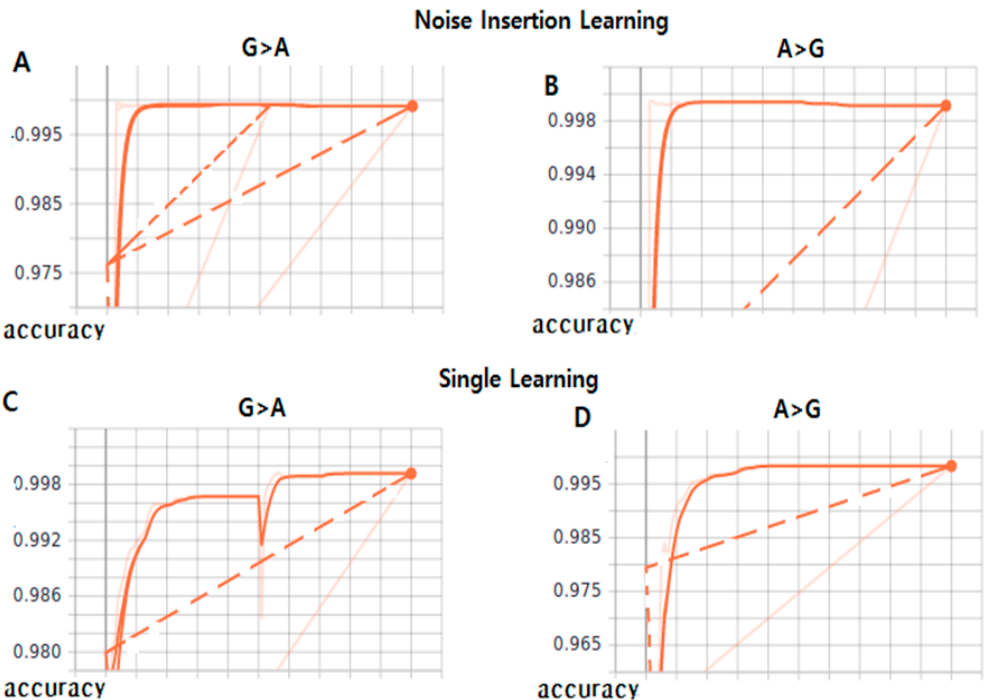
Figure 20. Graph comparing the accuracy of single learning and noise insertion learning: the vertical axis is the accuracy, the horizontal axis is the number of training; It looks like not different between noise insertion learning and single learning but this graph shows combinational learning to ( C ) from ( A ) or to ( A ) from ( C ); ( B ) and ( D ) is more stable aspect the accuracy.